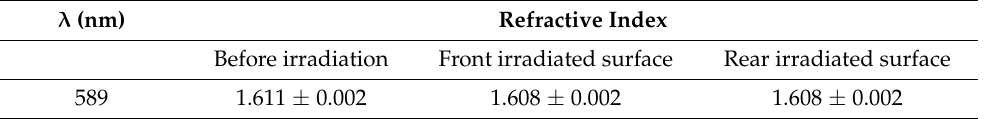
Table 2. Refractive index of the glass before and after irradiation with 222